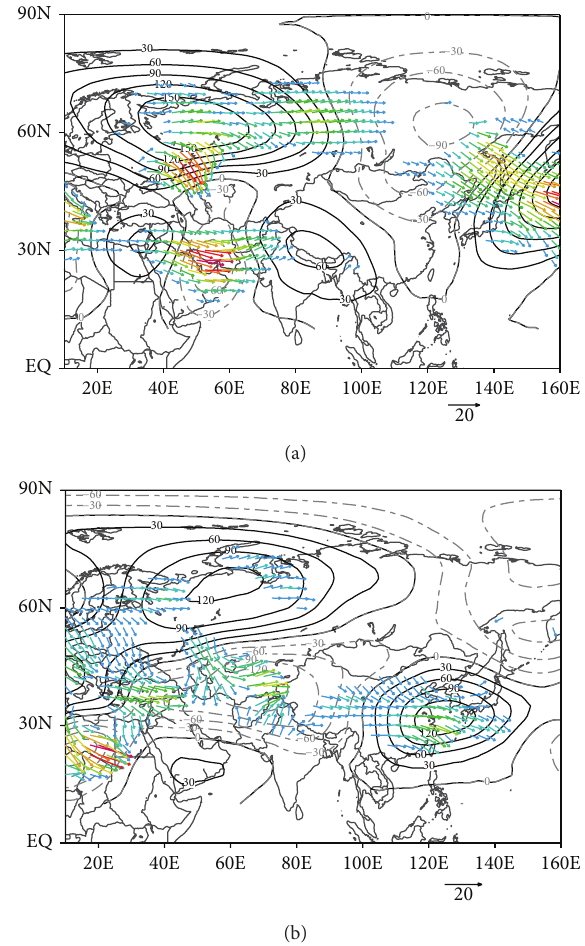
Figure 7: Composite of geopotential height anomaly (unit: gpm) and wave activity flux (unit: m/s 2 ) at 300 hPa: monthly averages of December 2007 (a)and January 2008 (b)(wave activity fluxless than 5 m/s 2 is